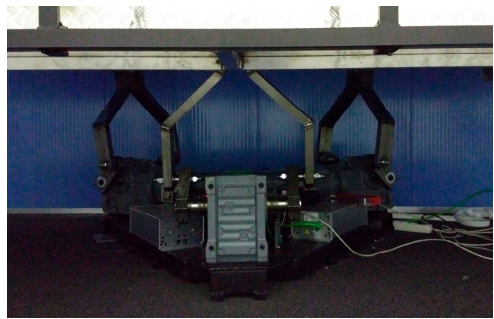
Figure 2. 3-DOF parallel platform.